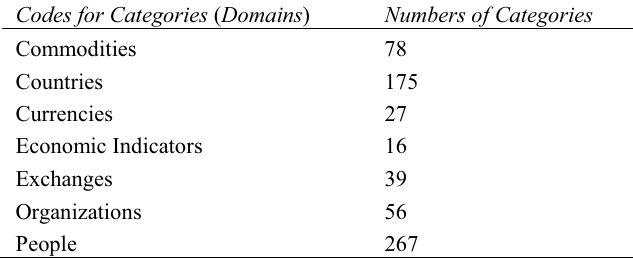
Table 2. Statistic of Categories of Reuters-21578 used in experiments Codes for Categories ( Domains